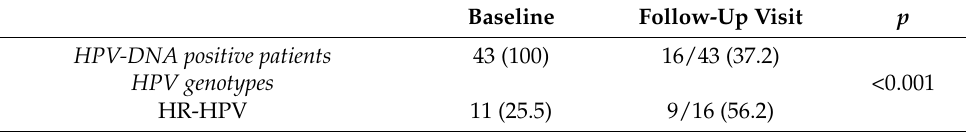
Table 2. HPV-DNA analysis and semen parameters at 3-month follow-up